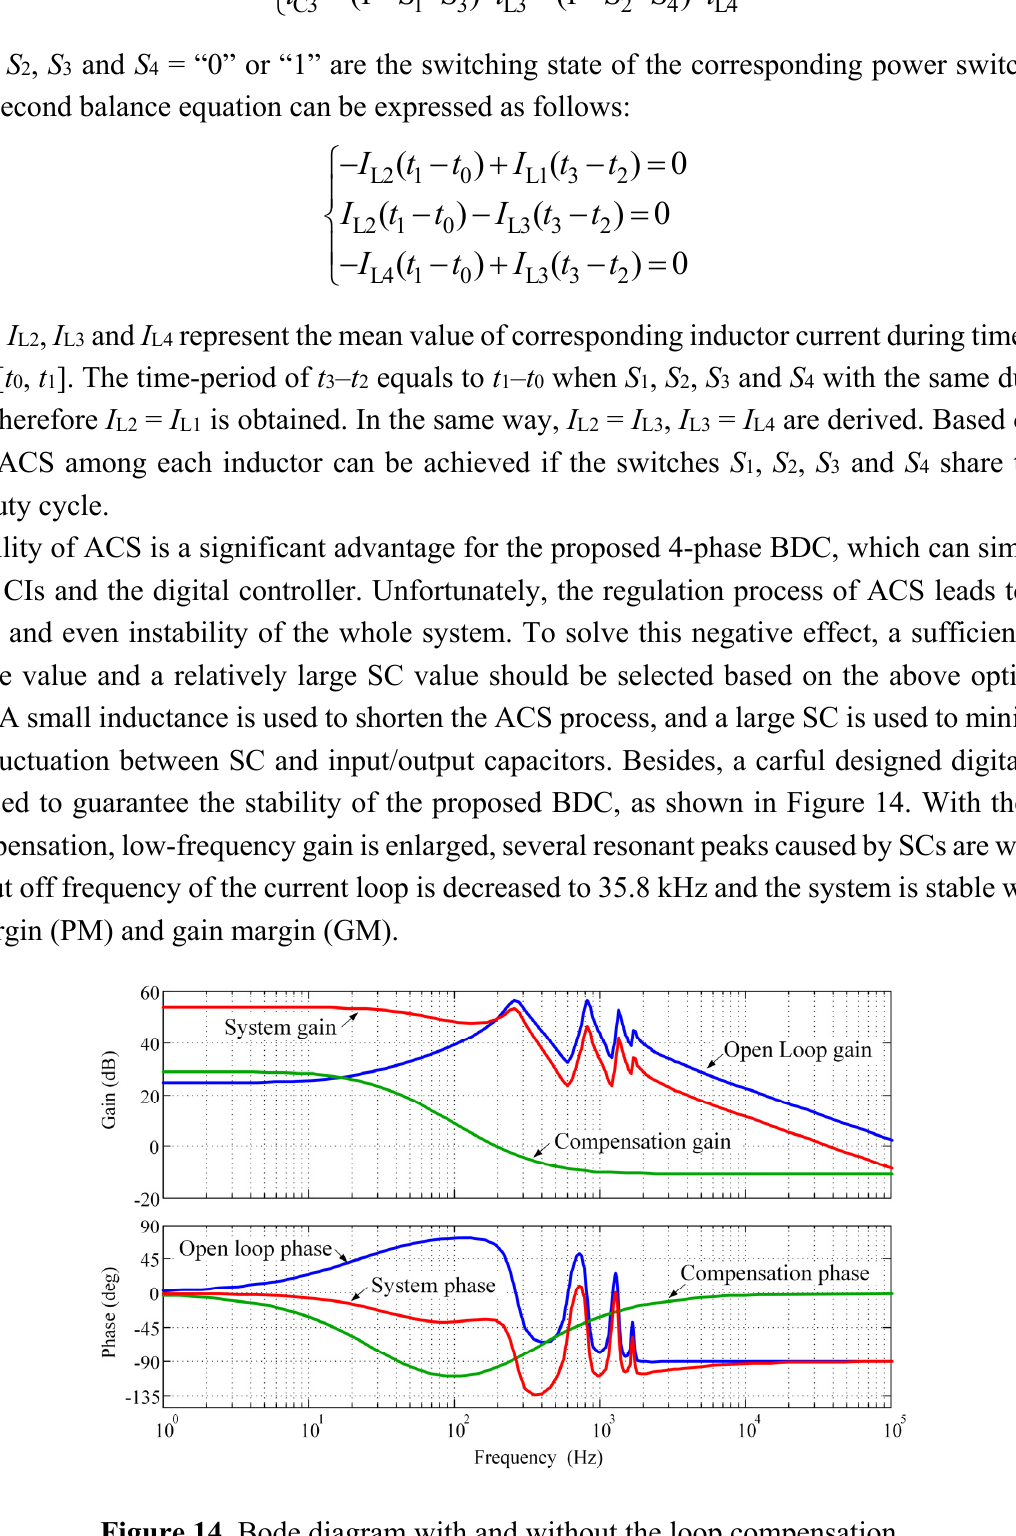
Figure 14. Bode diagram with and without the loop